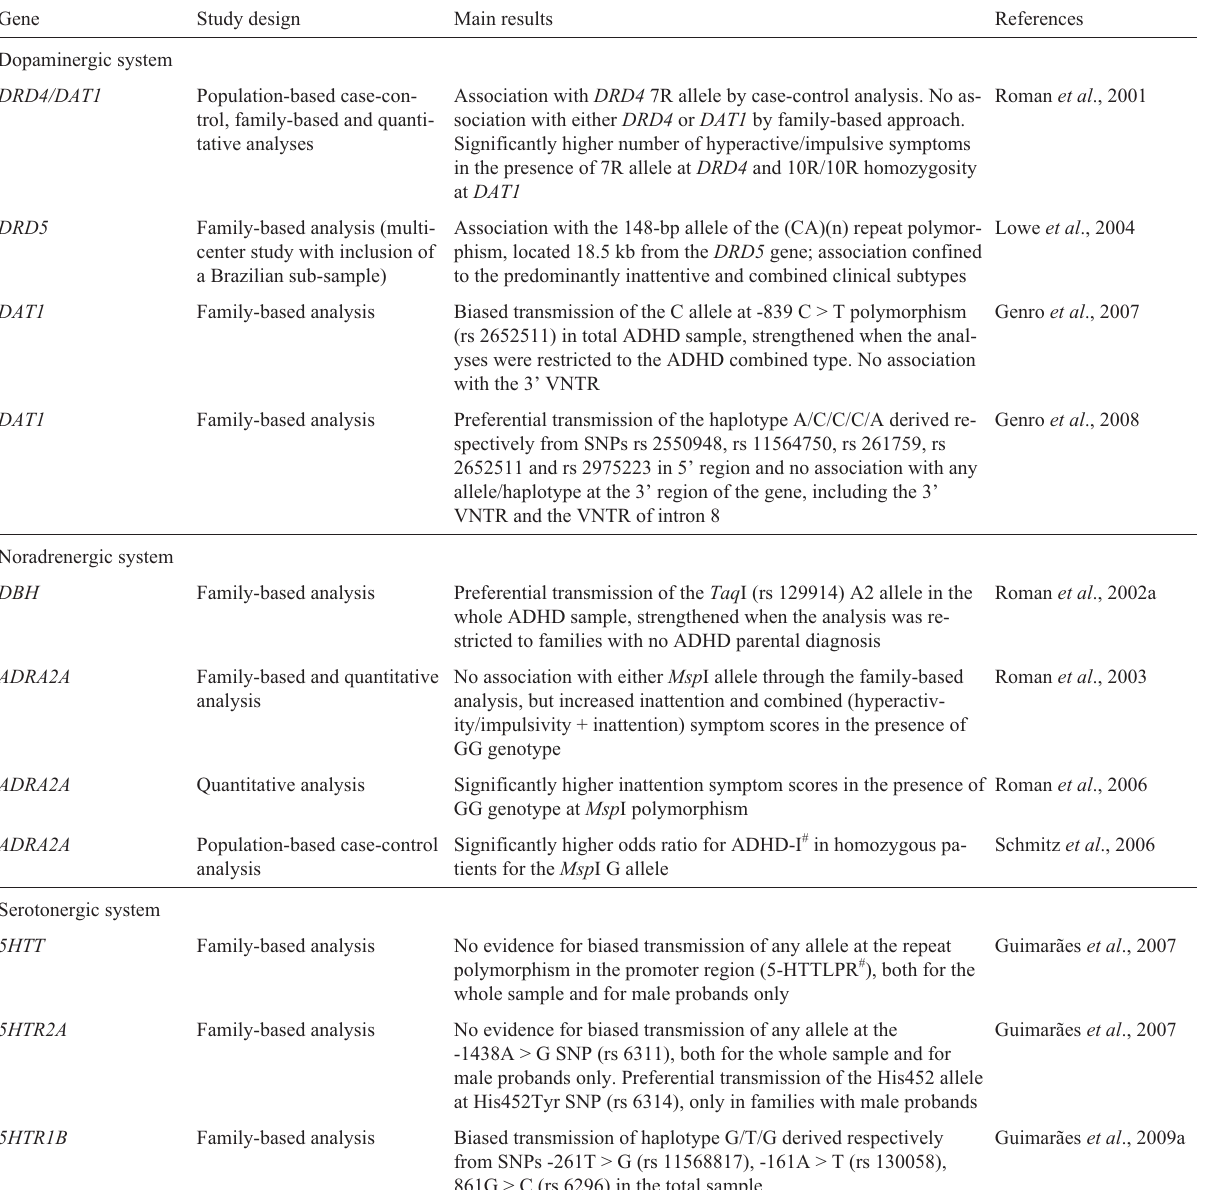
Table 1 - Association studies conducted in Brazilian children and